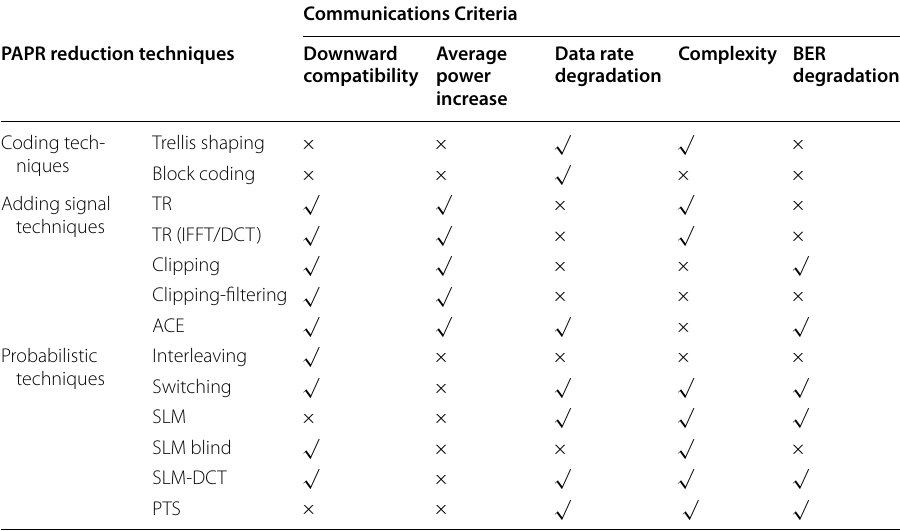
Table 1 Classification of PAPR reduction techniques Communications Criteria PAPR reduction